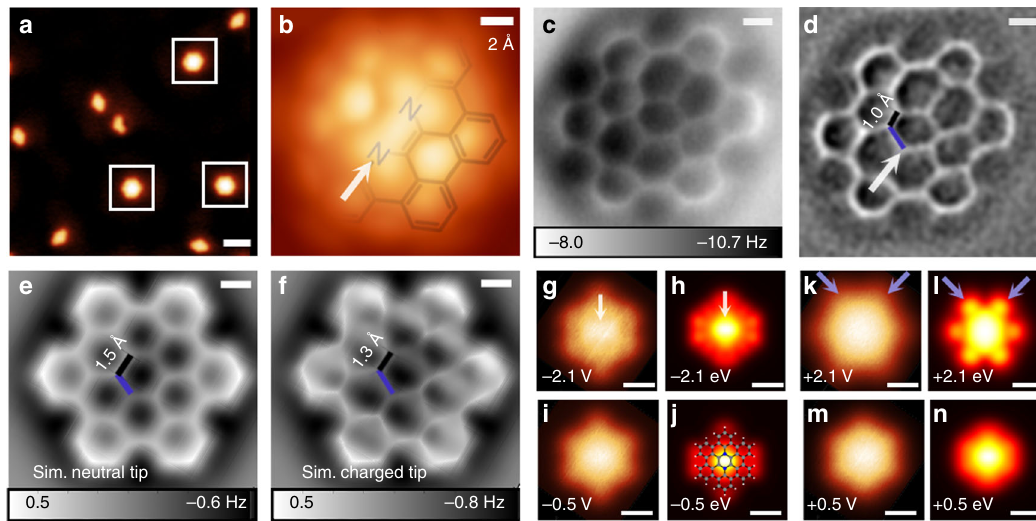
Fig. 5 On-surface homocoupling of precursor 5c yields fully planar and neutral diaza-HBC 7c on Ag(111). a Scanning tunneling microscopy (STM) overview of reaction product and unreacted species on Ag(111). V s = 30 mV, I t = 10 pA. b Constant-height STM data of diaza-HBC with partially superposed molecular model. V s = 5 mV. c Frequency-modulated atomic force microscopy (FM-AFM) and d Laplace- fi ltered FM-AFM data reveal details in the molecular structure. Apparent C = C distance 1.0 Å (black), and N – C 1.8 Å (blue). e FM-AFM simulations of 7c employing a neutral tip. Apparent C = C distance 1.5 Å (black), N – C 1.5 Å (blue). f FM-AFM simulations employing a negatively charged probe tip. Apparent C = C distance 1.3 Å (black), N-C 1.9 Å (blue). For simulation parameters see Methods. g – n Constant-height STM data ( g , i , k , m ) at different biases and corresponding ( h , j , l , n ) DFT simulations. White arrows point to N atoms oriented along the diaza-HBC symmetry axis. Scale bars ( a ) 20 Å, ( b – f ) 2 Å, ( g – n ) 5